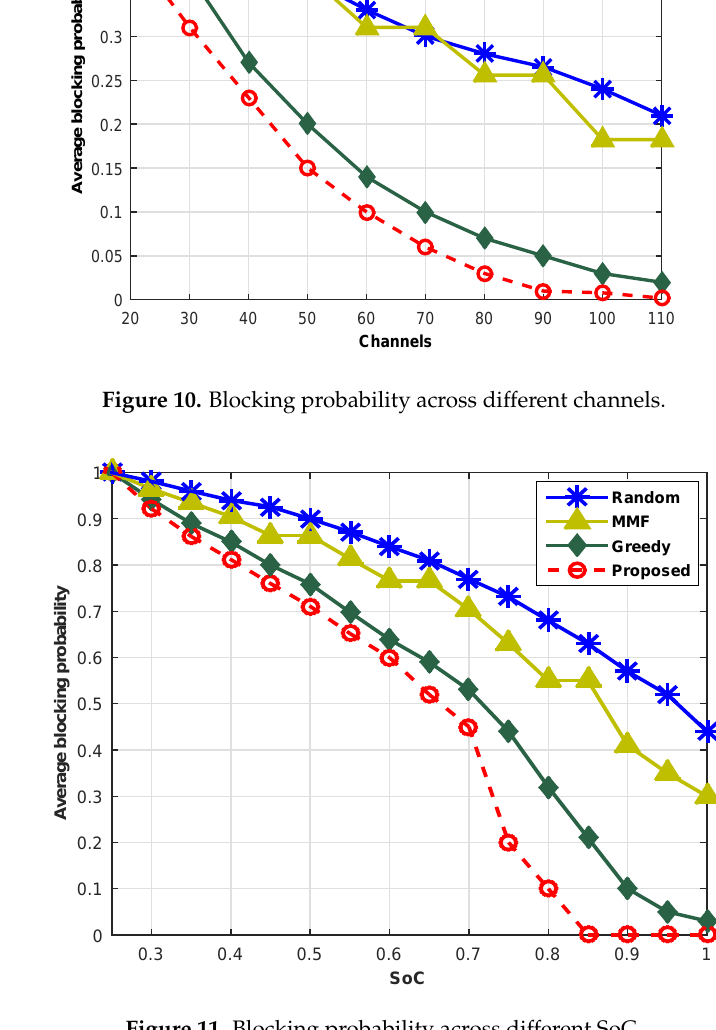
Figure 11. Blocking probability across different